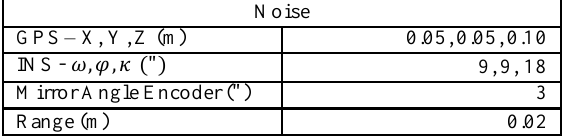
Table 3: Noise of Measurements in these Experiments